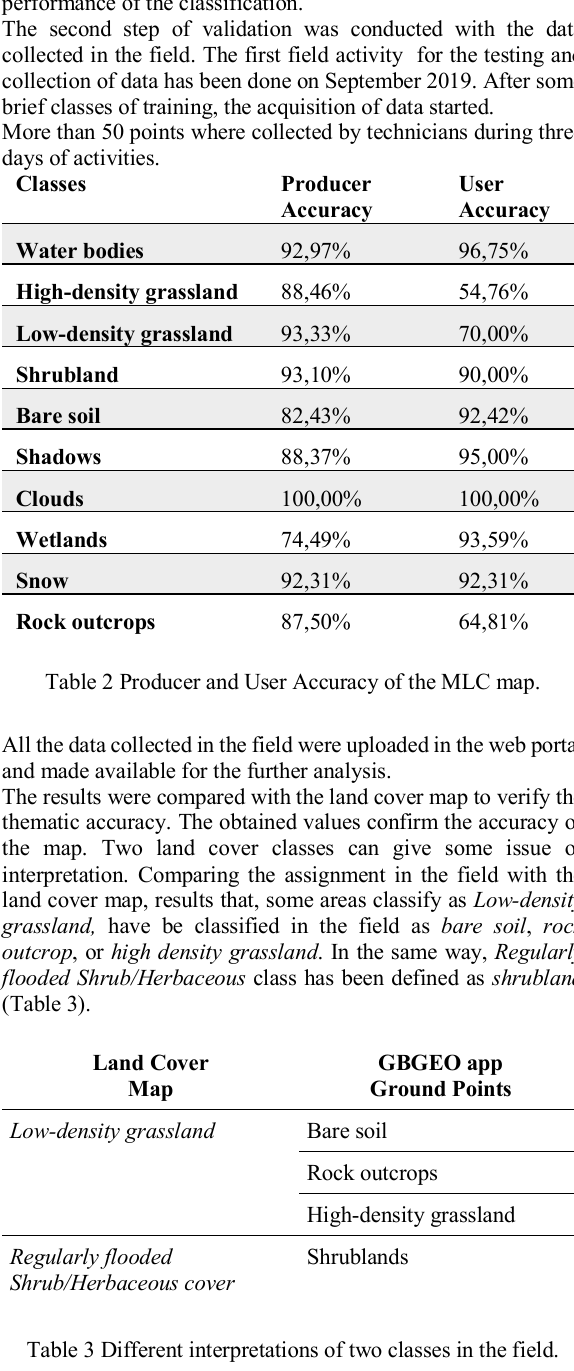
Table 3 Different interpretations of two classes in the